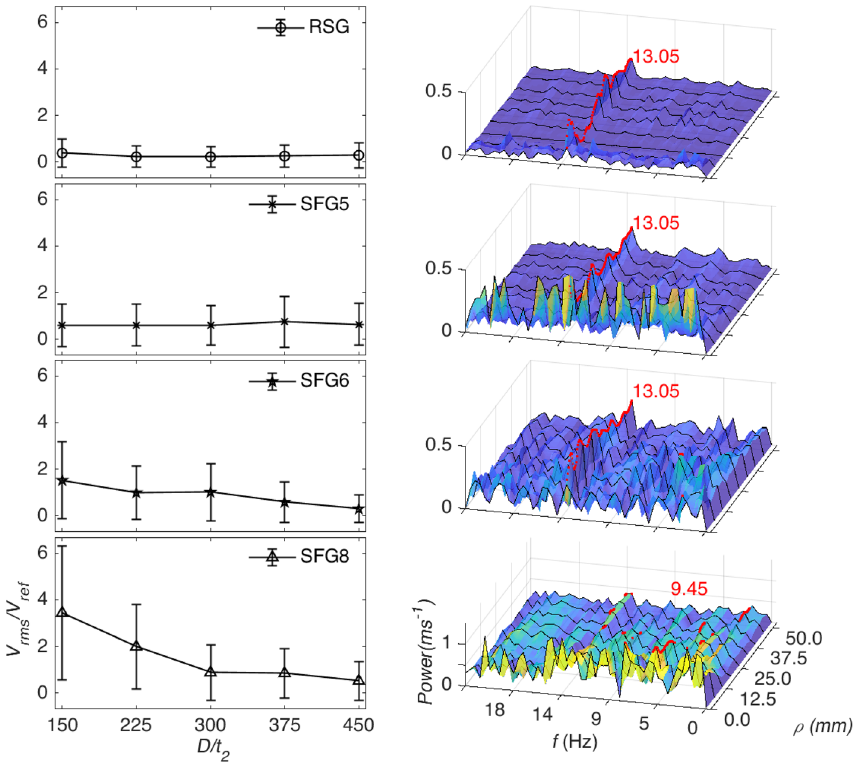
Figure 2. Left, mean and standard deviation of normalized V rms against the streamwise distance, L/t 2 of each insert. Right, power spectrum of each grid at all concentric square, ρ for turbulator distance, L/t 2 = 150. Note: The peak at each ρ is shown as red dots with the most dominant frequency in red text. (note: prepared in Matlab R2018A, https:// www. mathw orks. com/ produ cts/ matlab.